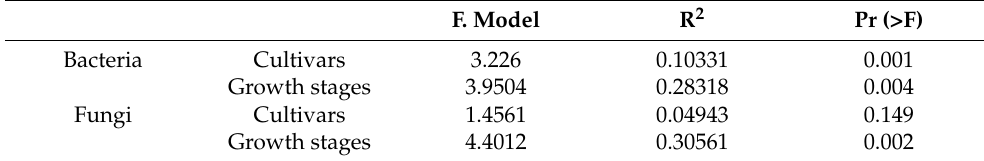
Table 2. PERMANOVA analysis results of the association of bacterial and fungal community structures.